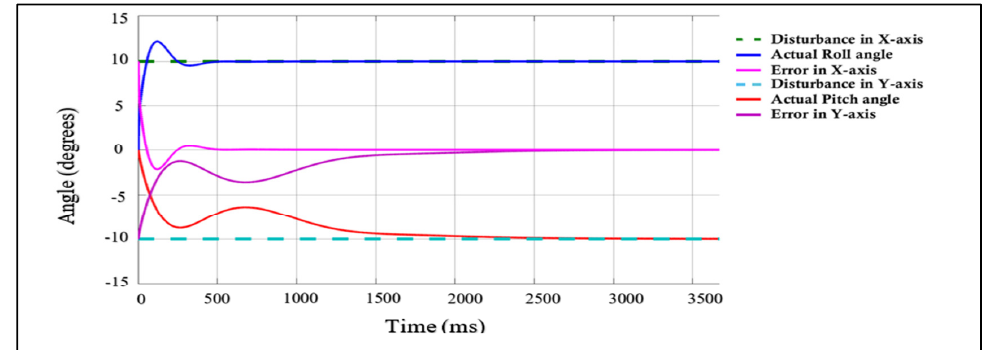
A. under tilt angle (10° on positive X-axis and -10° on negative